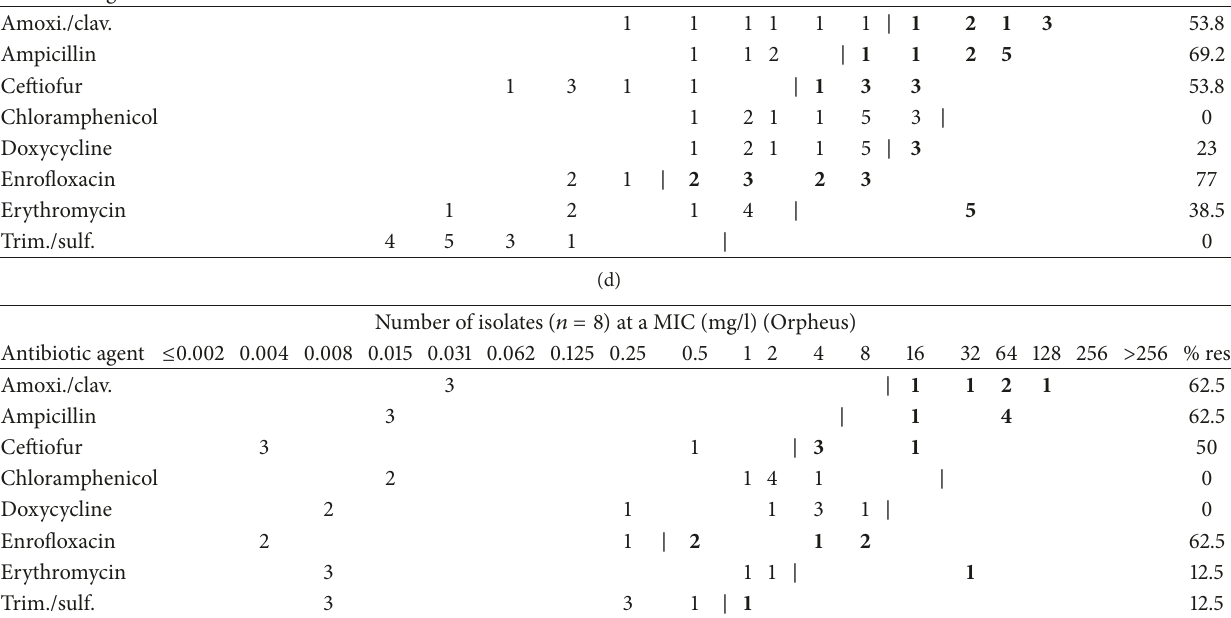
Number of isolates (𝑛 = 13) at a MIC (mg/l) (Magnetic